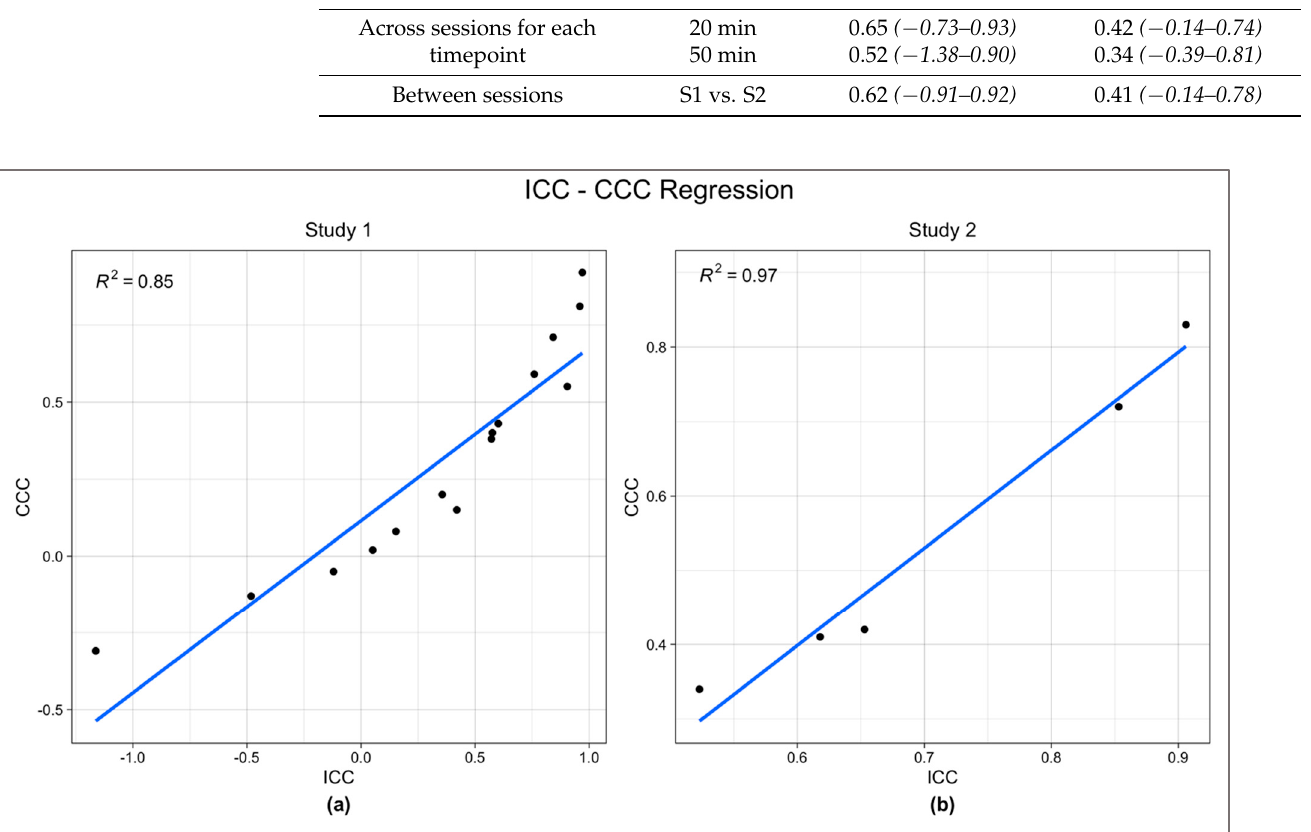
Figure 4. Simple linear regression analysis testing the correlation between ICC and CCC in Study 1 ( a ) and Study 2 ( b ). Both studies showed significant correlations (Study 1: R 2 = 0.97, F(1, 3) = 103.8, p = 0.002 ), (Study 2: R 2 = 0.97, F(1, 3) = 103.8, p = 0.002 ). In both studies CCC significantly predicted